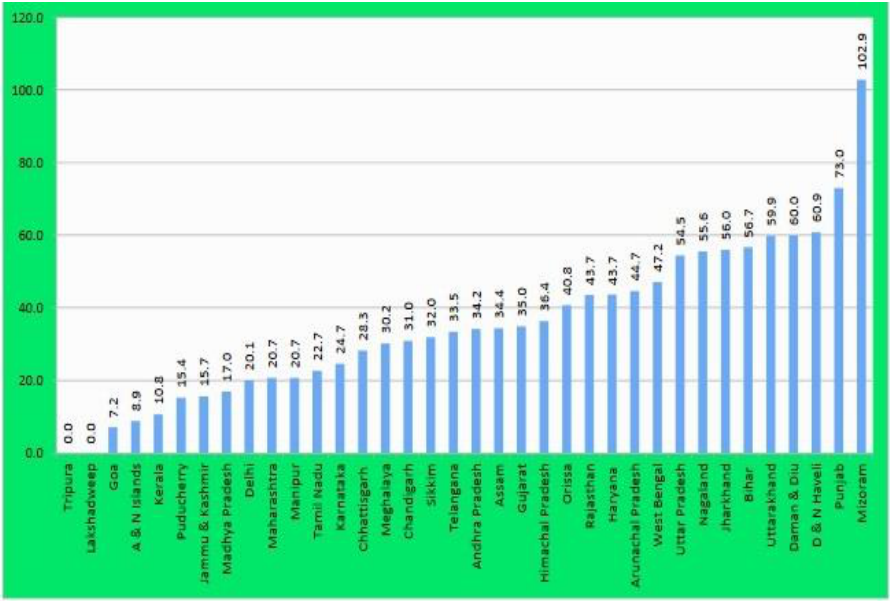
Fig. 1. Severities of road accidents across States during 2015